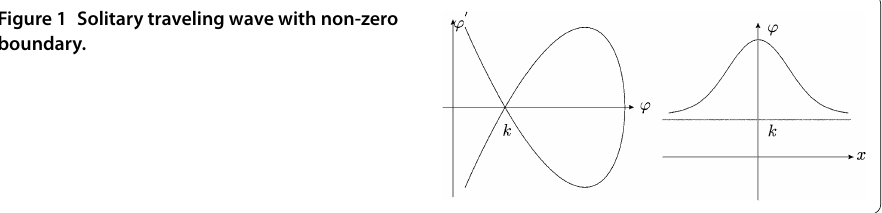
Figure 1 Solitary traveling wave with non-zero